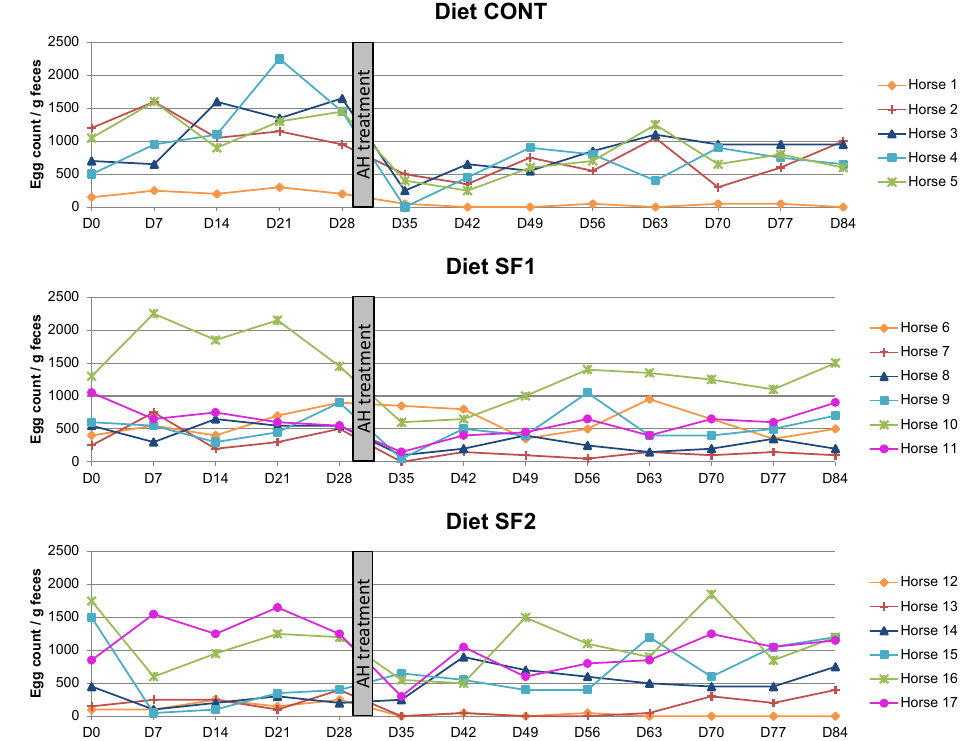
Figure 2. Individual changes in fecal egg count (FEC) in naturally infected horses fed a control diet (CONT), a diet providing 1.53 g (SF1) or 3.06 g (SF2) DM pelleted sainfoin/kg BW/day. Each line refers to an individual horse. FEC was assessed on a weekly basis from D0 to D84. After four weeks, all individuals were treated with an anthelmintic drug (AH